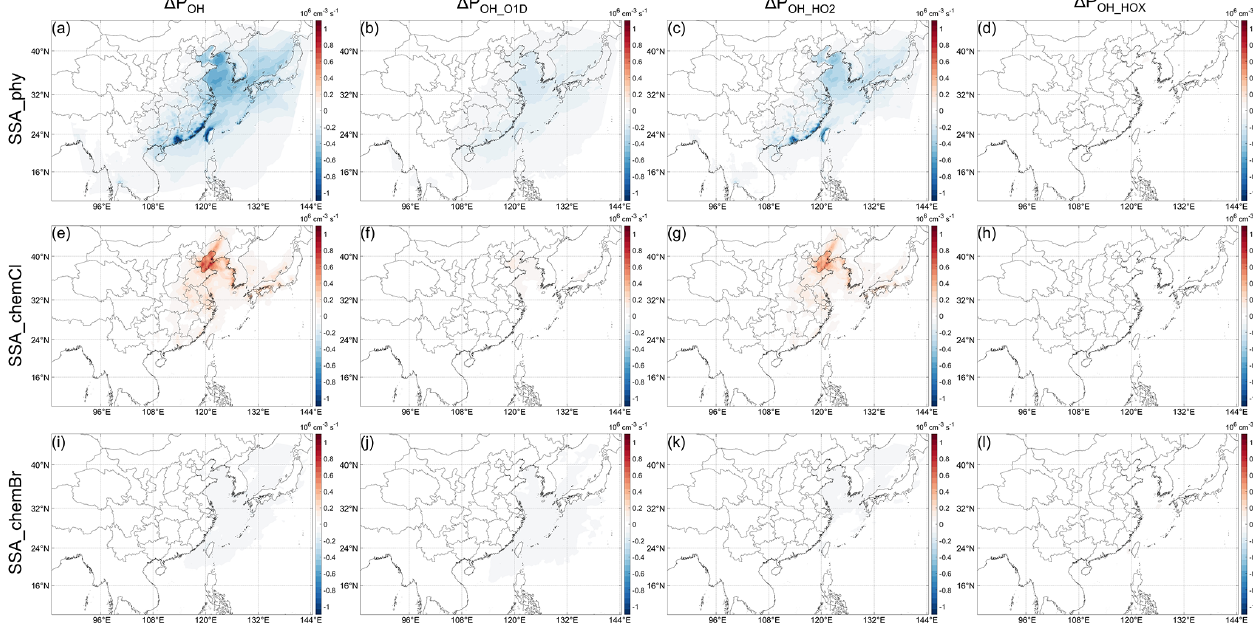
Figure 5. Decomposition of Fig. 4a–d (SSA): the changes in P OH , P OH_O1D , (cid:49) P OH_HO2 , and (cid:49) P OH_HO X caused by (a) – (d) the extinction effect of SSA, denoted as SSA_phy, (e) – (h) Cl chemistry (only the activation of Cl through ClNO 2 ), and (i) – (l) Br